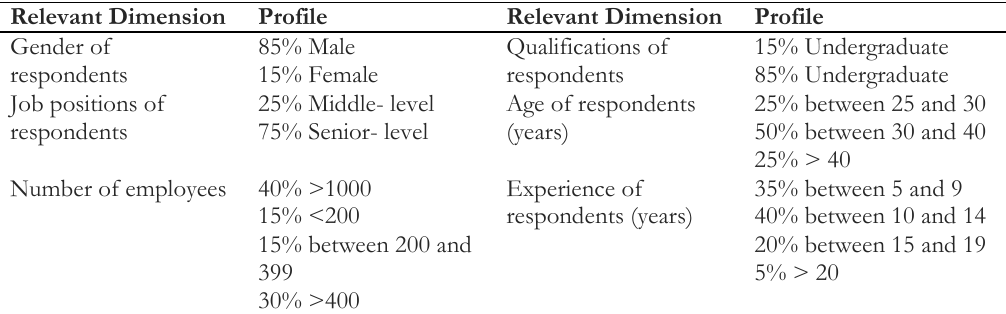
Table 3. The respondents’ demographic